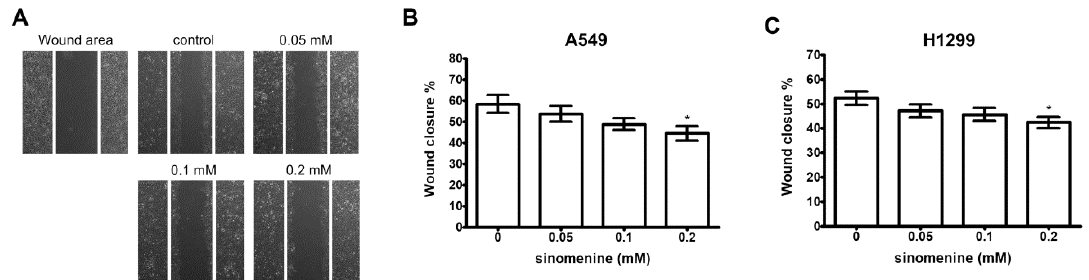
Figure 2. Effect of sinomenine on migration of A549 and H1299 cells. ( A ) A549 cell monolayers were scraped by a sterile micropipette tip and the cells were treated with various doses of sinomenine for 24 h. Cells that migrated to the wounded region were photographed (100× magnification). The wound area of the cultures of A549 cells ( B ) and H1299 cells ( C ) were quantified in four fields in each treatment, and data were calculated from three independent experiments. Data are presented as mean ± S.D. of three independent experiments. * p < 0.05 compared with the untreated control.